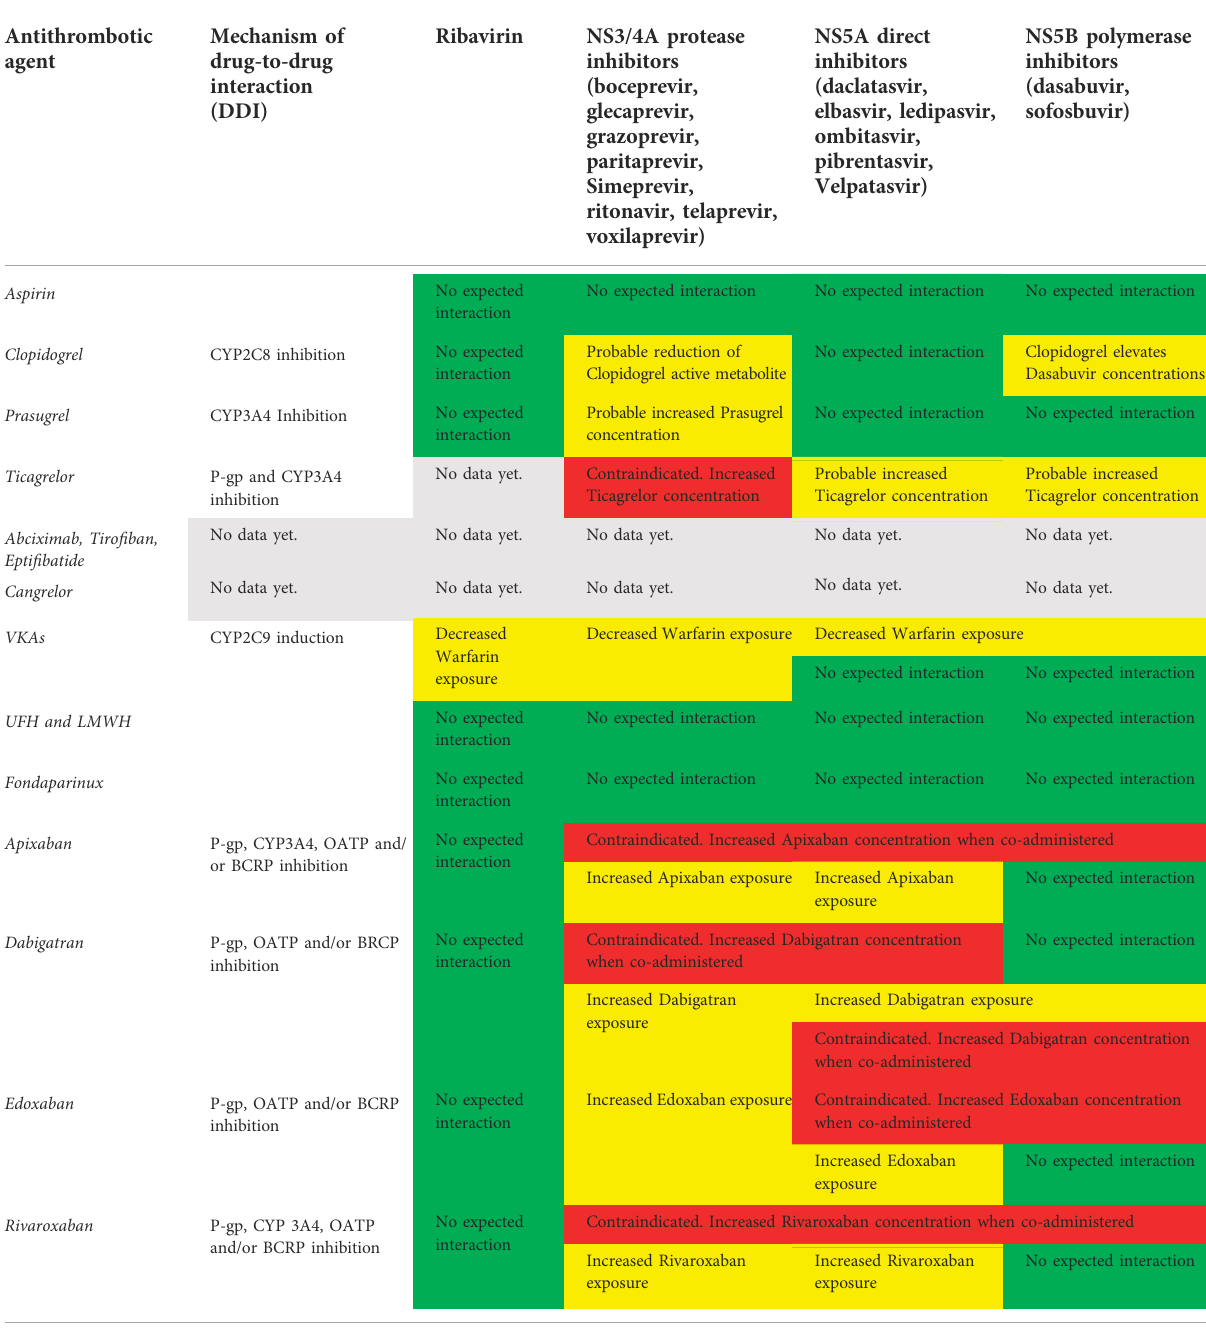
TABLE 1 Potential drug-drug interactions between HCV antiviral treatments and antithrombotic agents. In green: safe coadministration with no expected interactions based on current evidence. In red: unsafe and harmful coadministration based on strong evidence available. In yellow: careful clinical and lab (e.g. INR, hemoglobin, platelets, D-dimer) monitoring required due to less evidence